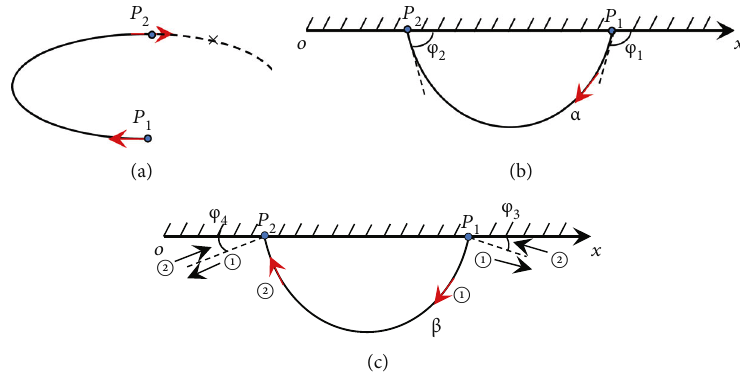
Figure 3: Determination of inclination angle φ : (a) continuous slip line; (b) along slip line α ; (c) along slip line β